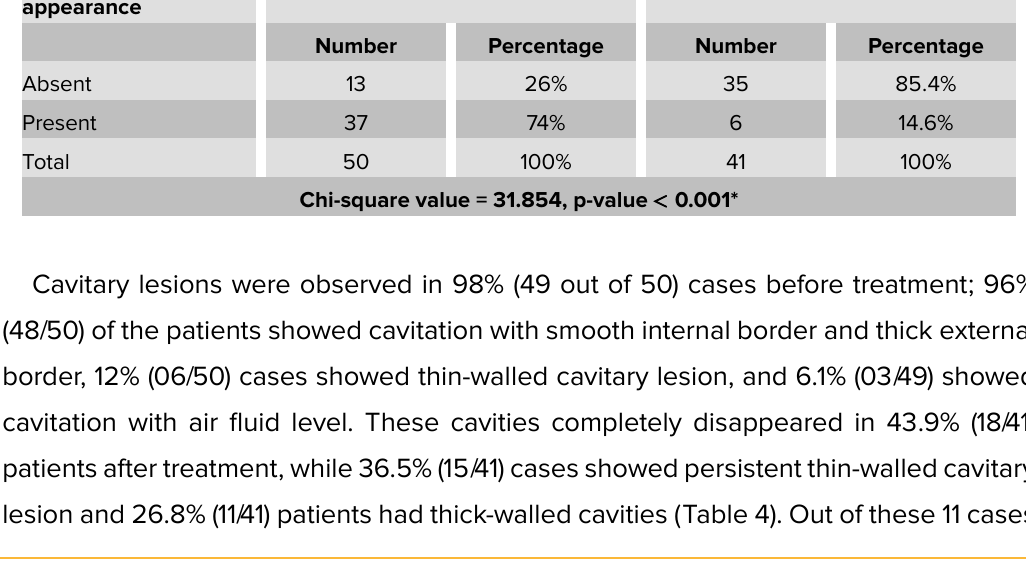
TABLE 2: Frequency distribution of tree-in-bud appearance in pre- and posttreatment cases. Tree-in-bud appearance